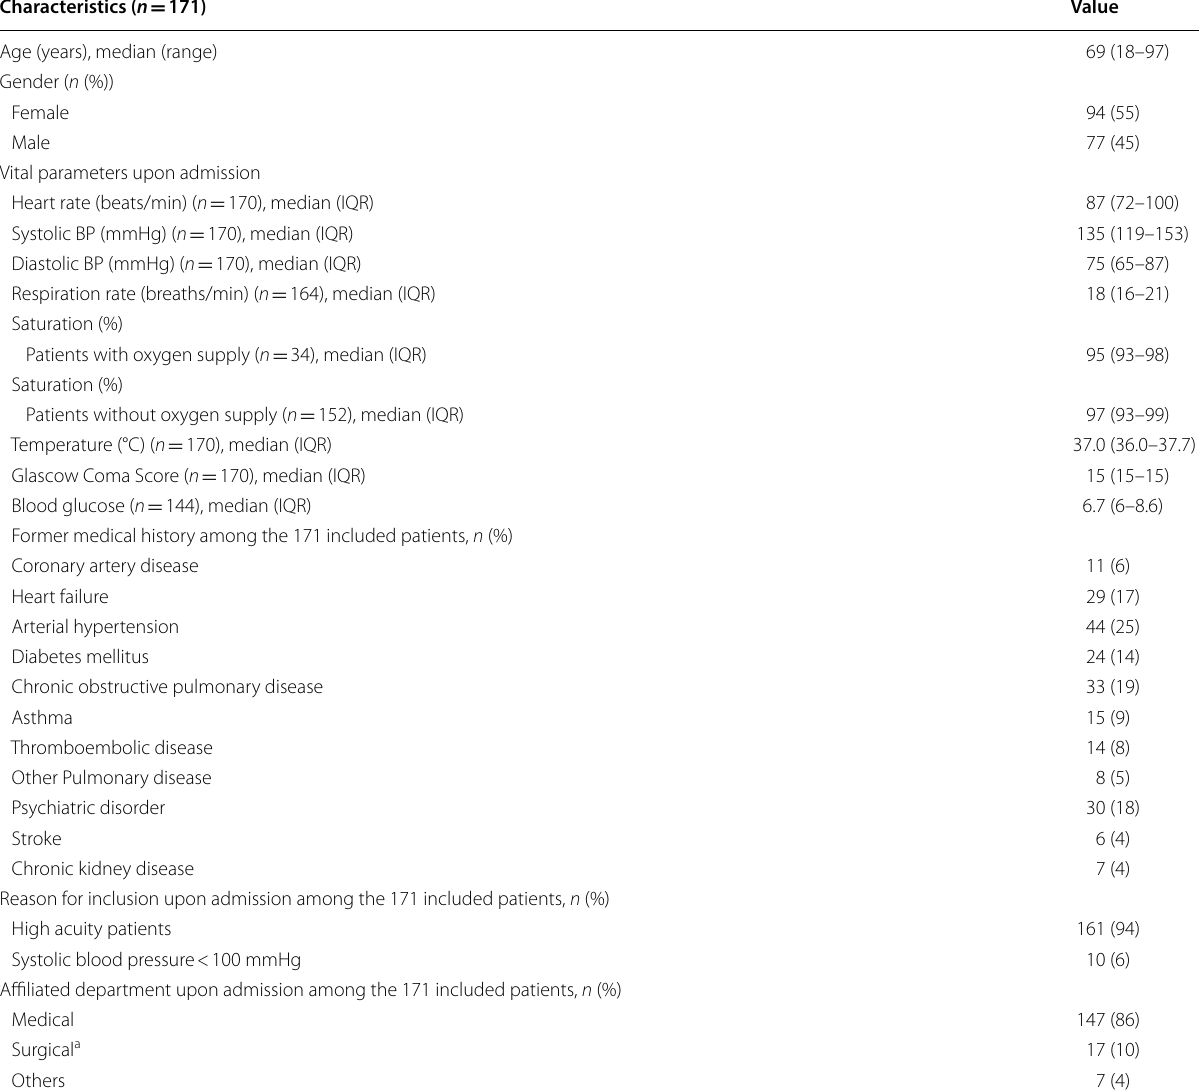
Number of patients with an ultrasonography examination sufficient for diagnostic evaluation for each protocol ( N ) and for the individual pathology ( n ). Cases of no ultrasonography clips are left out Fcu focused cardiac ultrasonography, Flus focused lung ultrasonography, Faus focused abdominal ultrasonography, Lcu limited compression ultrasonography